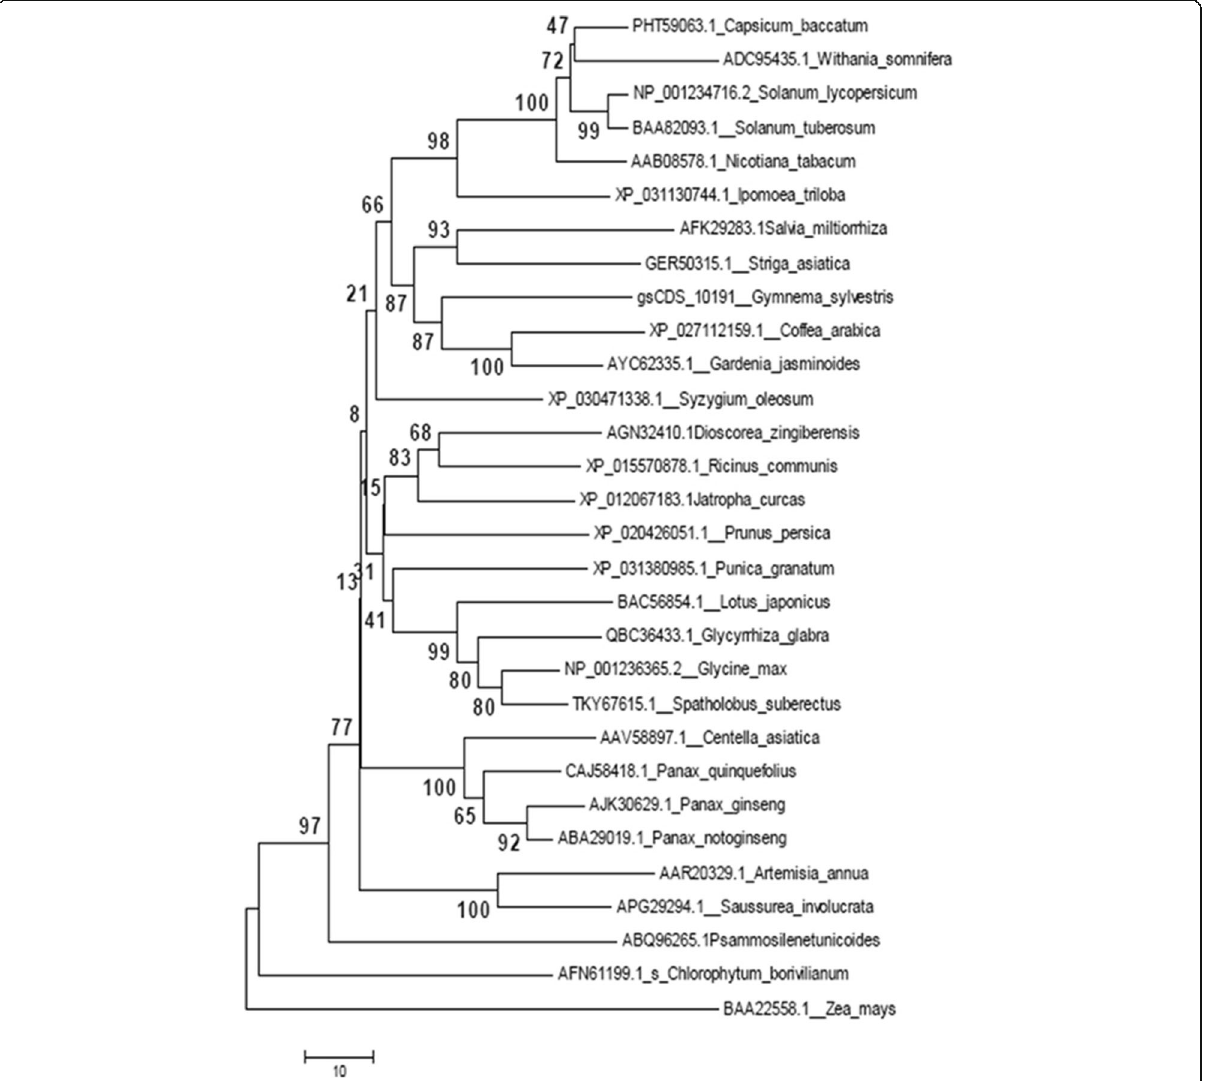
Fig. 4 Phylogenetic analysis SQS gene based on Maximum Likelihood (ML)